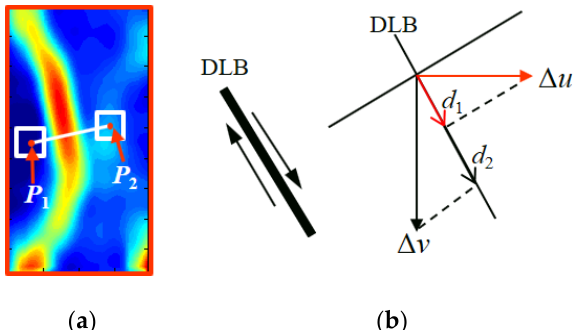
Figure 3. Principle of dislocation displacement calculation: ( a ) Layout of measuring points; ( b ) decomposition of displacement.